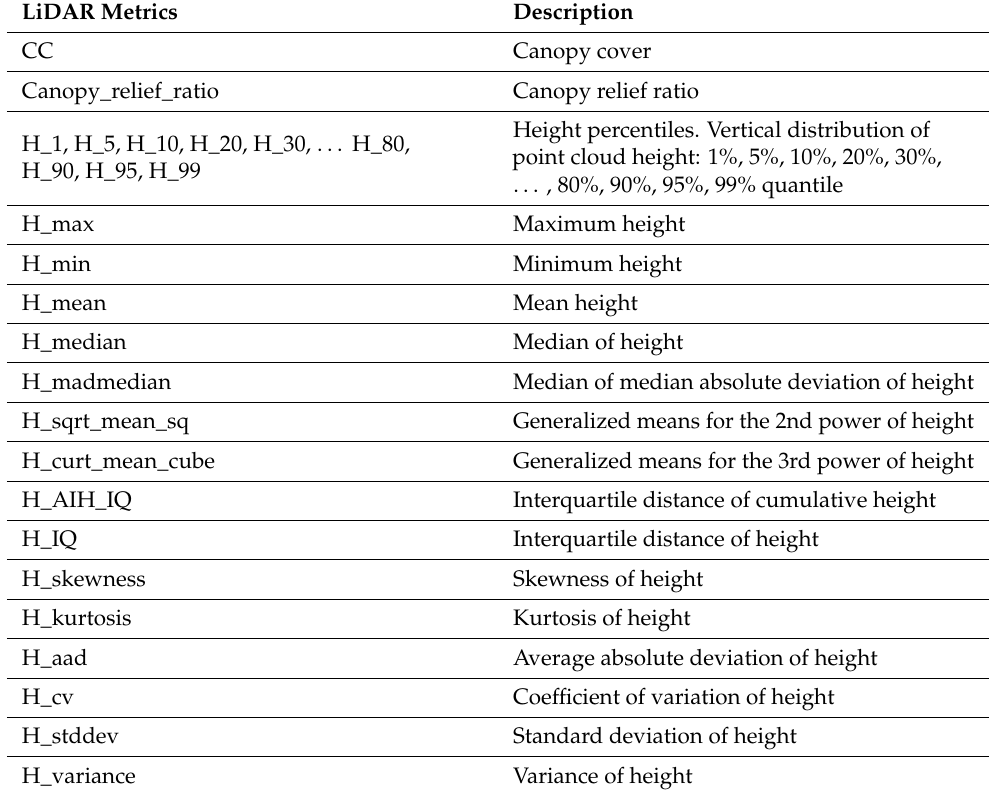
Table 4. Summary of the metrics extracted from ALS data used in this